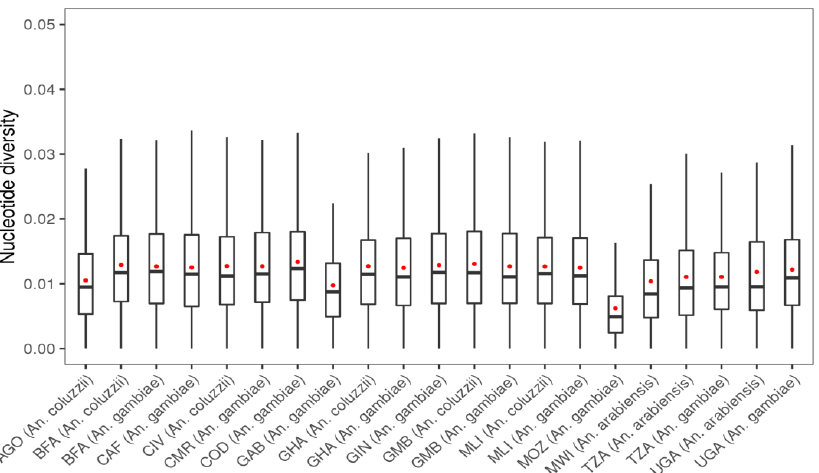
Figure A2. Median of nucleotide diversity in a window of 500 bp across the genomic region of the Fruitless gene; red points indicate the mean of the nucleotide diversity; AGO: Angola; BFA : Burkina Faso; CAF : Central African Republic; CIV : Côte d’Ivoire; CMR : Cameroon; COD : Democratic Republic of Congo; GAB : Gabon; GHA : Ghana; GIN : Guinea; GMB : Gambia; MLI : Mali; MOZ : Mozambique; MWI : Malawi; TZA : Tanzania; UGA : Uganda.